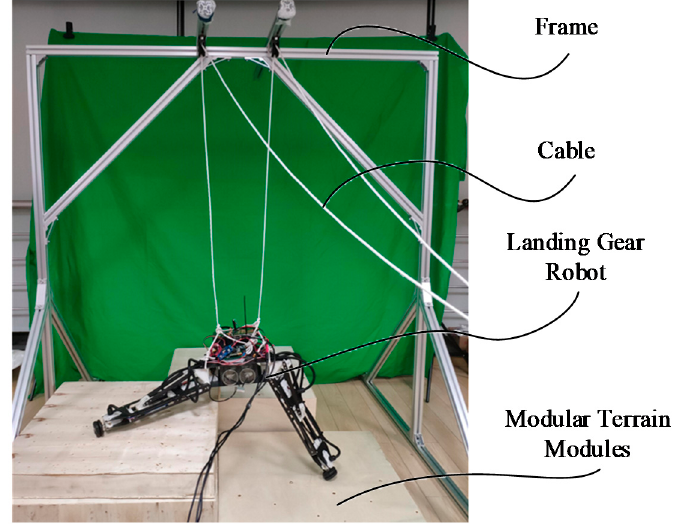
Figure 9. Experiment platform.